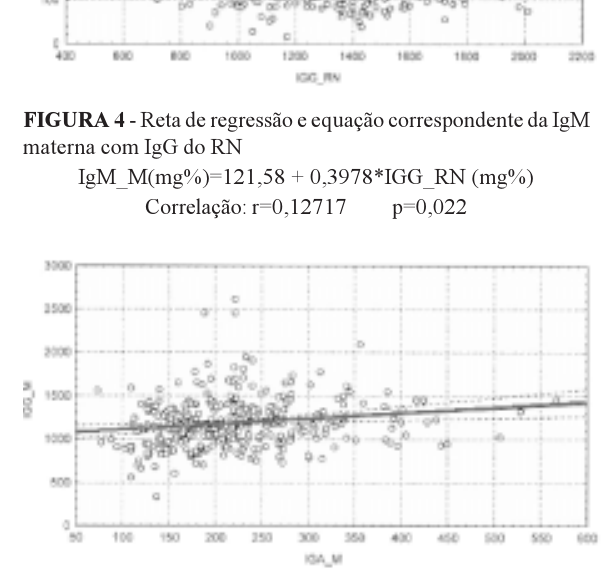
FIGURA 6 - Reta de regressªo e equa(cid:231)ªo correspondente